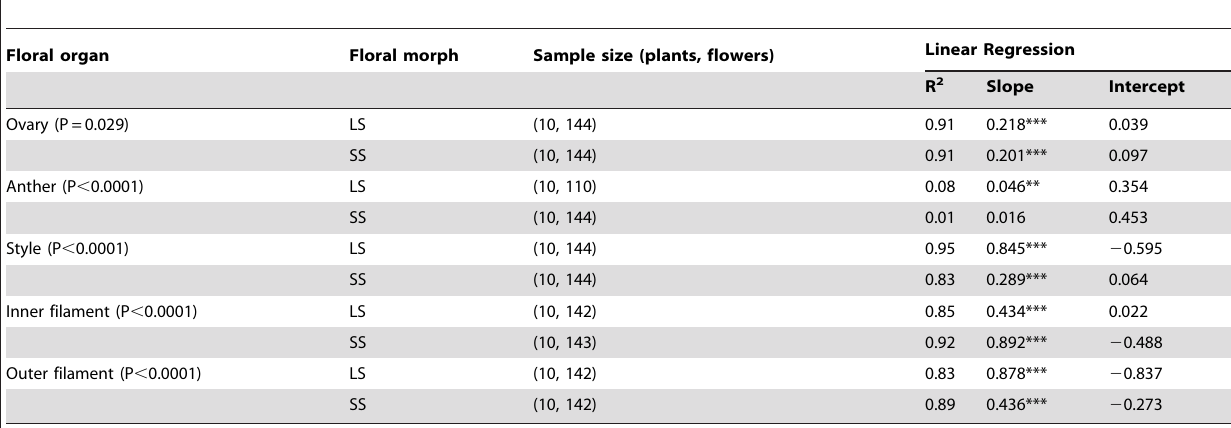
Table 2. Linear regression of relative growth rates of floral organs against bud length for long-styled (LS) and short-styled (SS) flowers of Polygonum jucundum.